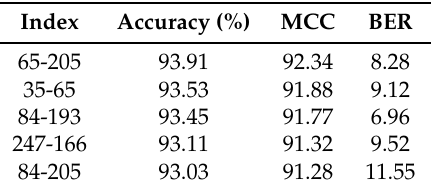
Table 11. Highest accuracy results of RBM using the amino acid property two-index combinations from Table 10.